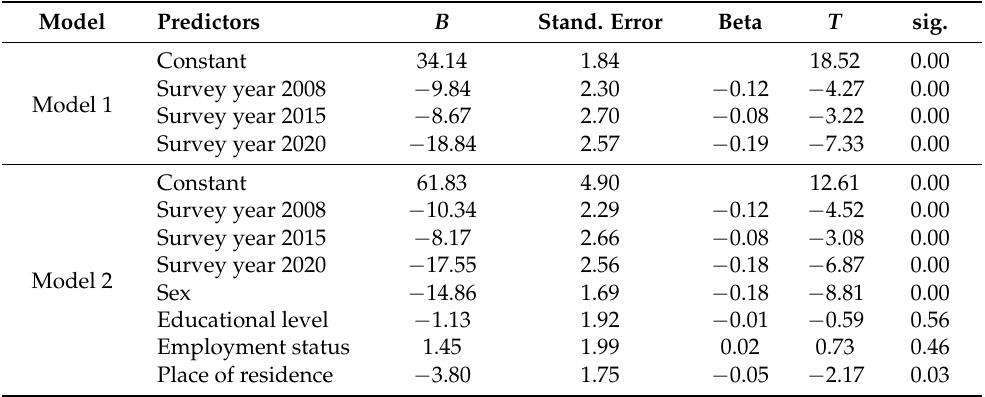
Table 4. Regression parameters for predictors of per capita consumption (young adults between 2004 and